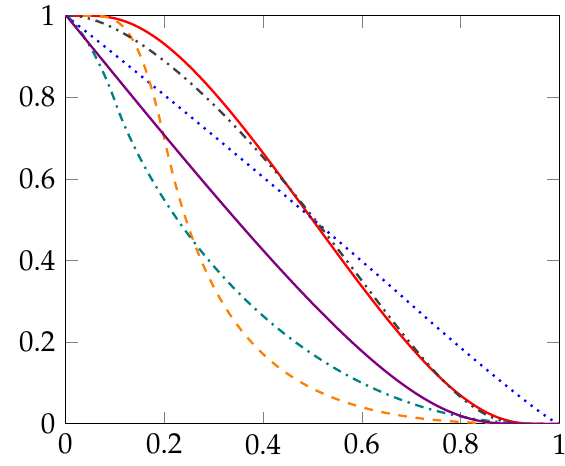
Figure 2. Plots of possible blending functions.